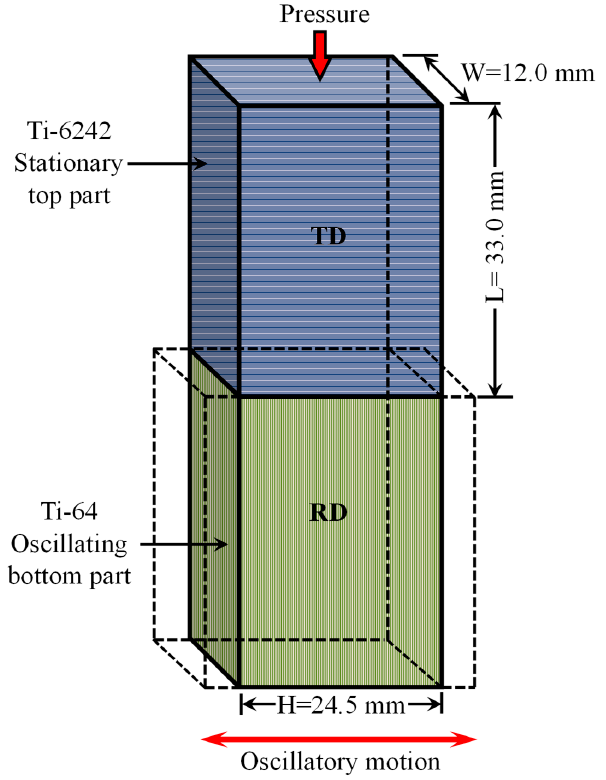
Table 3. Process parameters used for linear friction welding (LFW) of Ti-64 to Ti-6242.